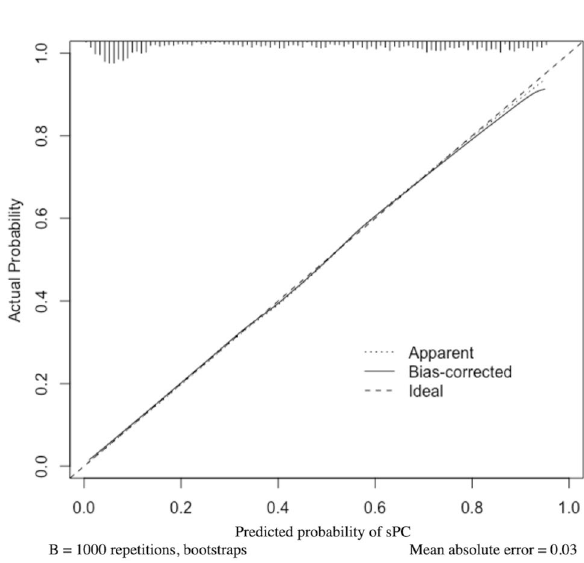
Figure 3. Calibration plots for the risk models to predict